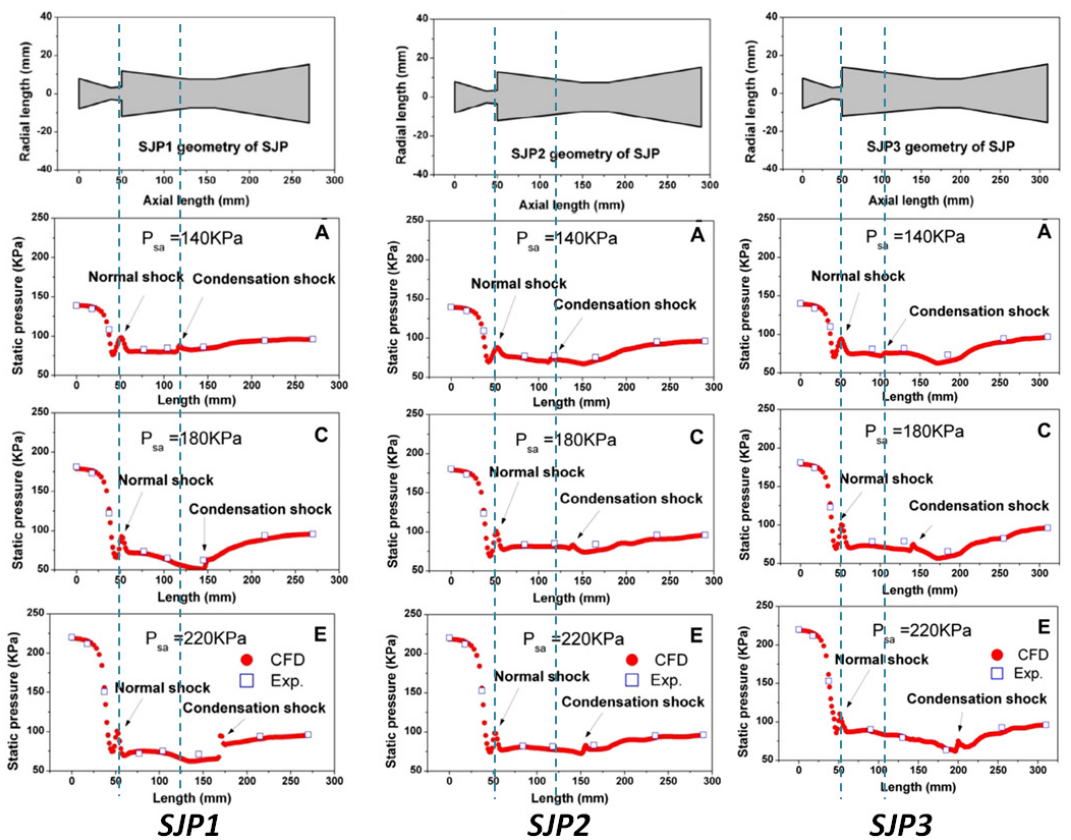
Figure 29. Axial static pressure along the wall of the ejector [92].